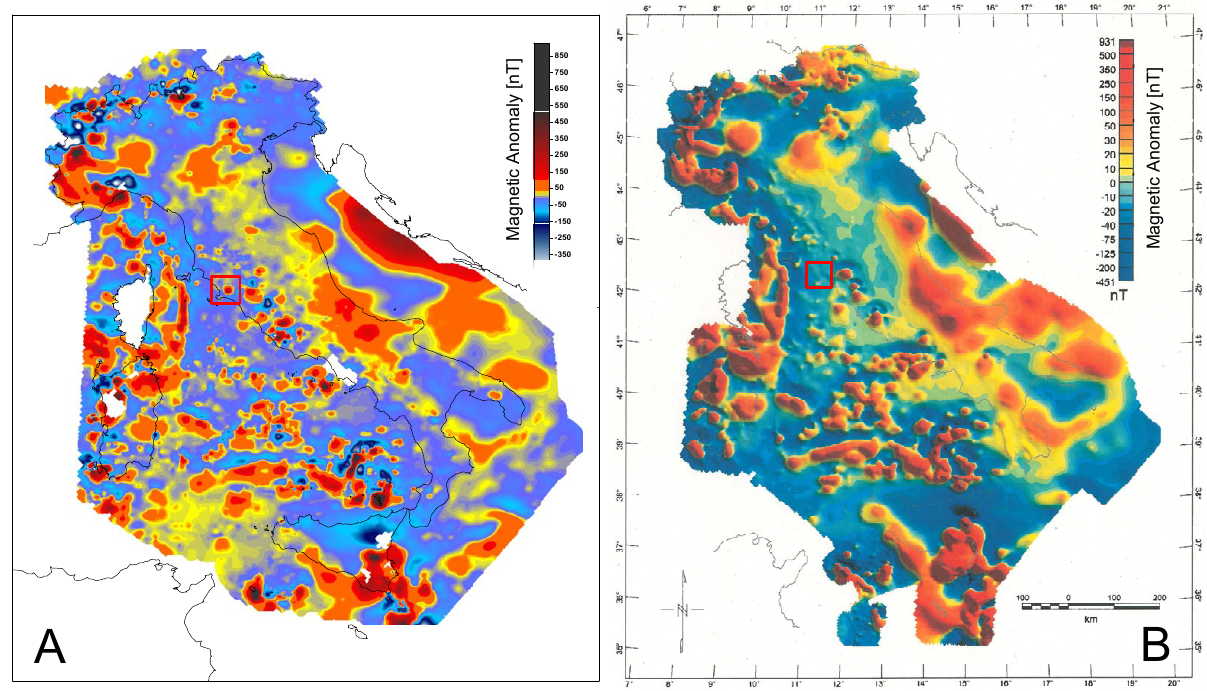
Figure 2. Total intensity magnetic anomaly maps: A) ground level from Italian database; B) aeromagnetic from AGIP/ENI database. In both maps, the red rectangles show the area referred to in this